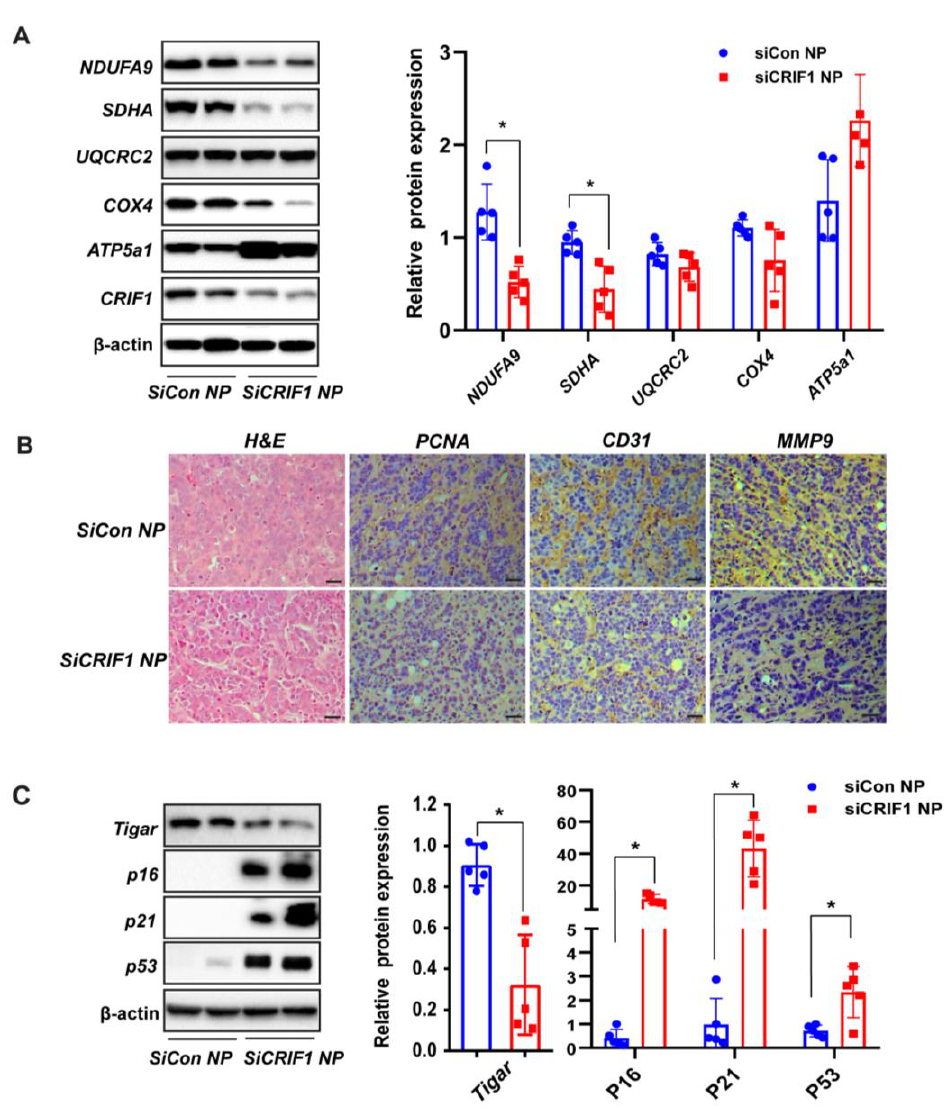
Figure 6. CRIF1 siRNA-encapsulated PLGA nanoparticles impaired mitochondrial function and suppressed the cell cycle. ( A ) mitochondrial OXPHOS complex subunits in tumor tissues were detected by immunoblotting and then quantified by densitometric analysis. ( B ) Isolated tumors were stained with H&E, PCNA, CD31, MMP9. Scale bar, 50 μm. ( C ) TIGAR, p16, p21, and p53 protein expressions were detected by Western blotting and then quantified by densitometric analysis. All data are presented as means ± SEM of at least three independent experiments ( n = 5 mice in each group; * p < 0.05 vs. siCon NP group).